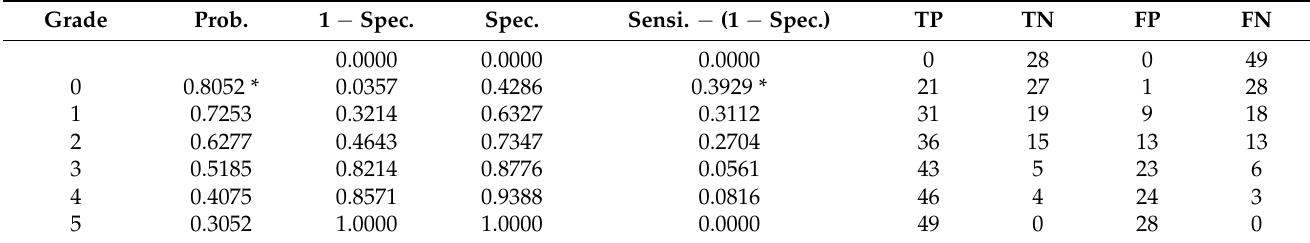
Table 5. Predictors of dysphagia (+) in a logistic regression analysis.